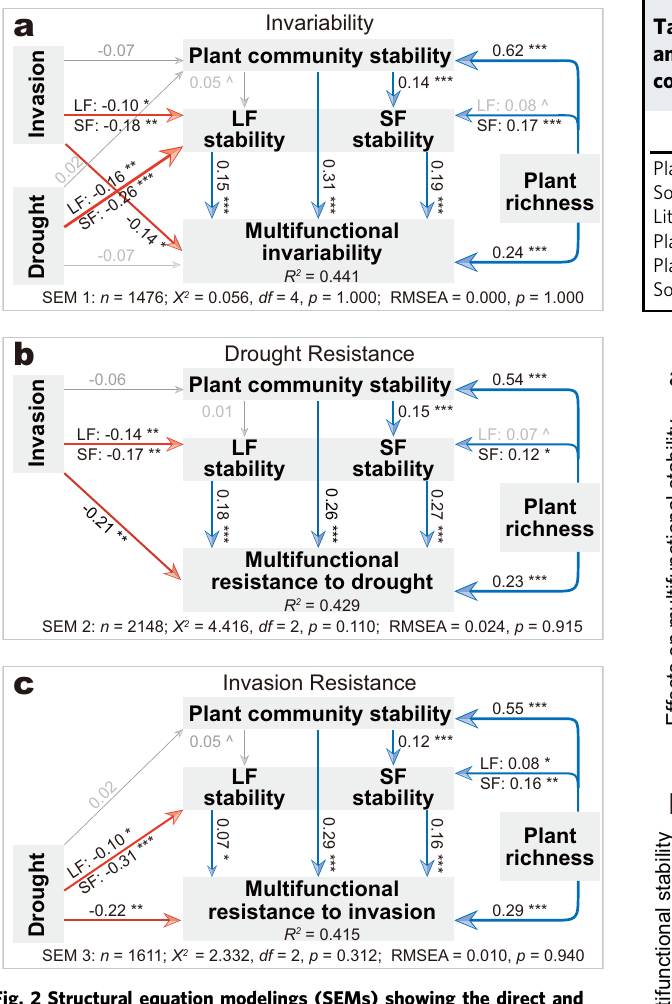
Fig. 2 Structural equation modelings (SEMs) showing the direct and